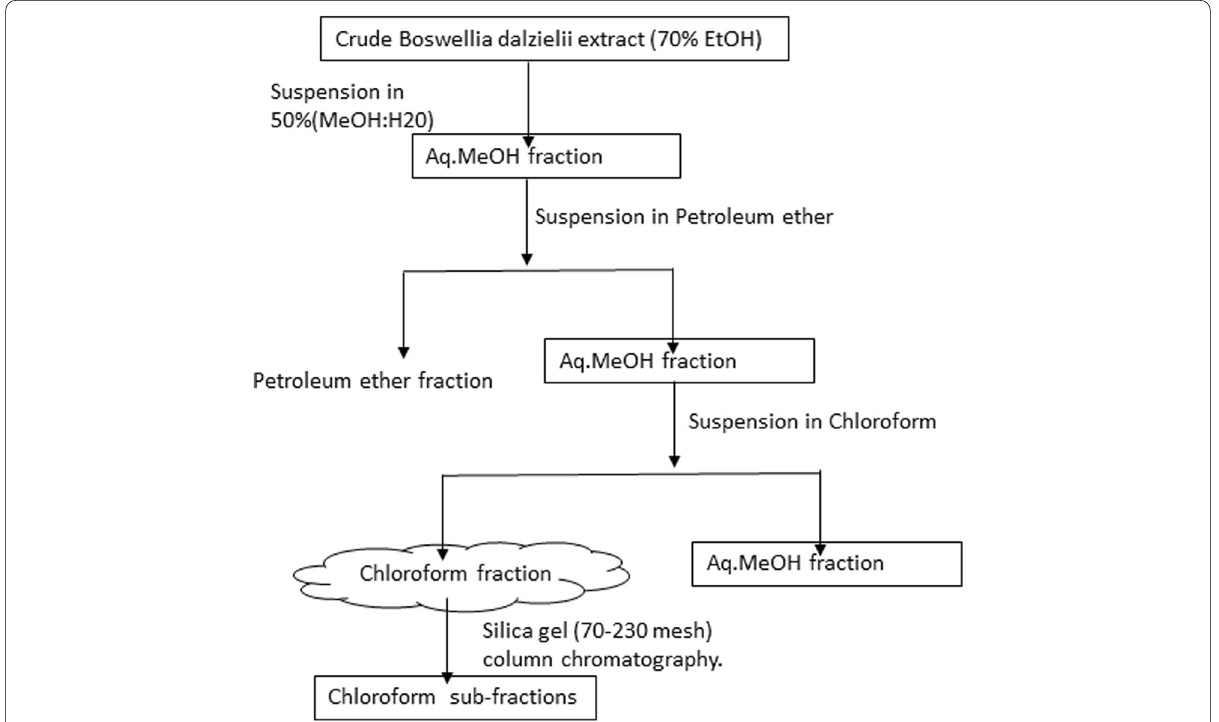
Fig. 1 Extraction and fractionation of Boswellia dalzielii stem